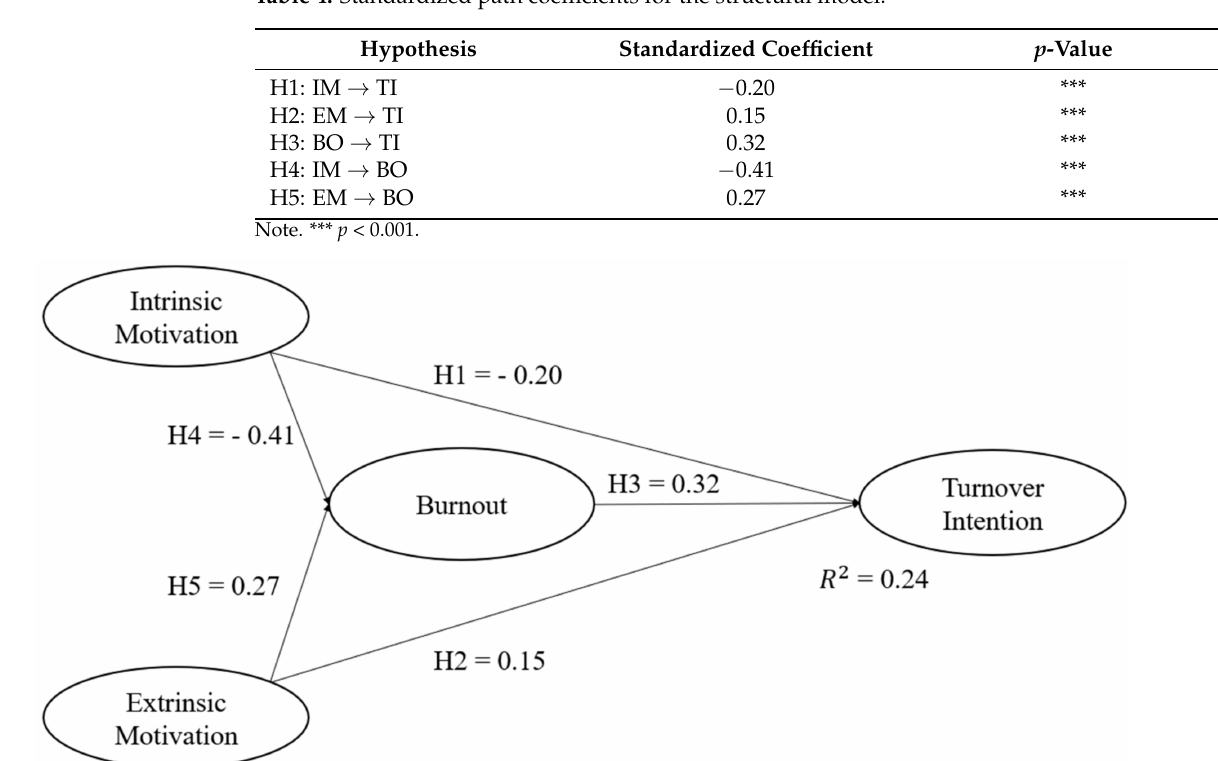
Table 4. Standardized path coefficients for the structural model.